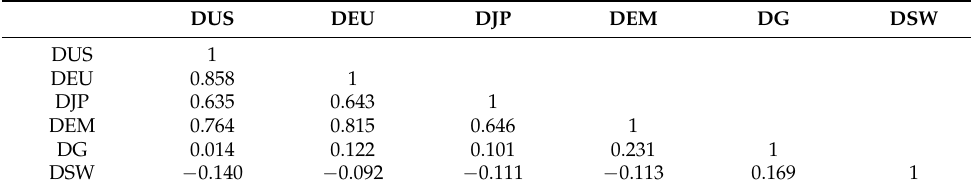
Table 2 contains unconditional correlation coefficients. Table 2. Correlation Matrix of Asset Returns. Monthly Data: 1999M2–2021M7 (270 Obs.). DUS DEU